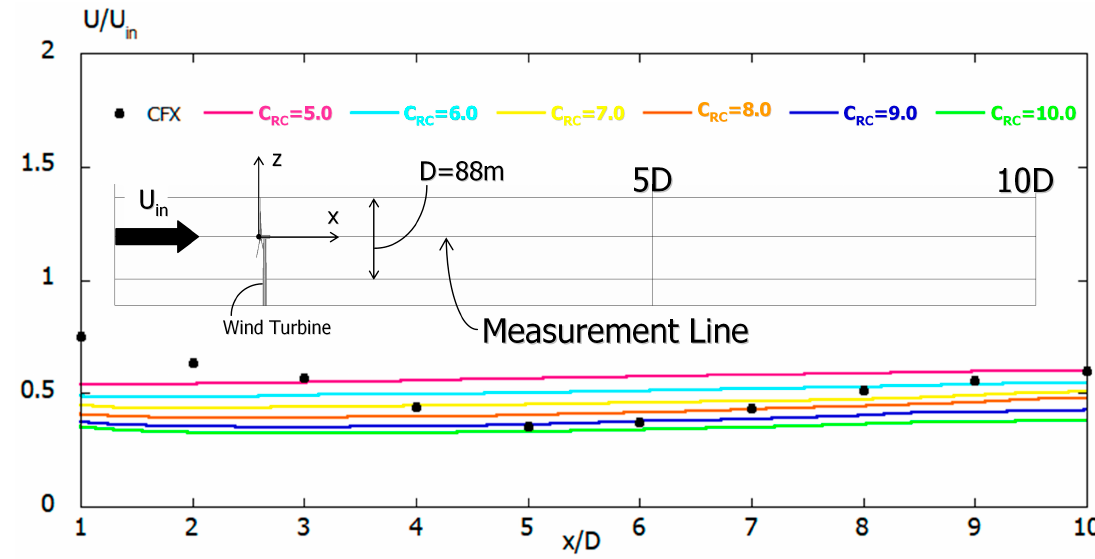
Figure 19. Comparison of time-averaged U-velocity space distribution at the center of the wind turbine hub with simulation results of time-averaged field for a real wind turbine.